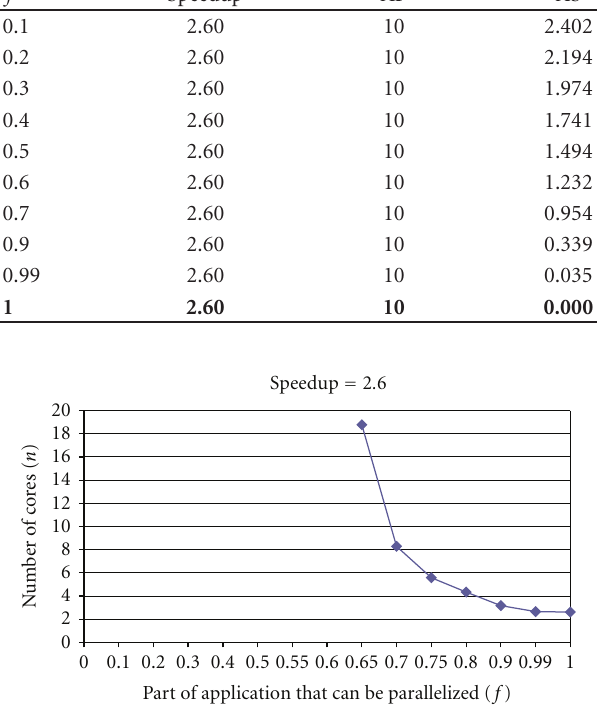
Figure 15: Number of cores as a function of f —according to Amdahl’s law, to achieve speedup of 2.6 it is required at least 65% of application parallelism and 19